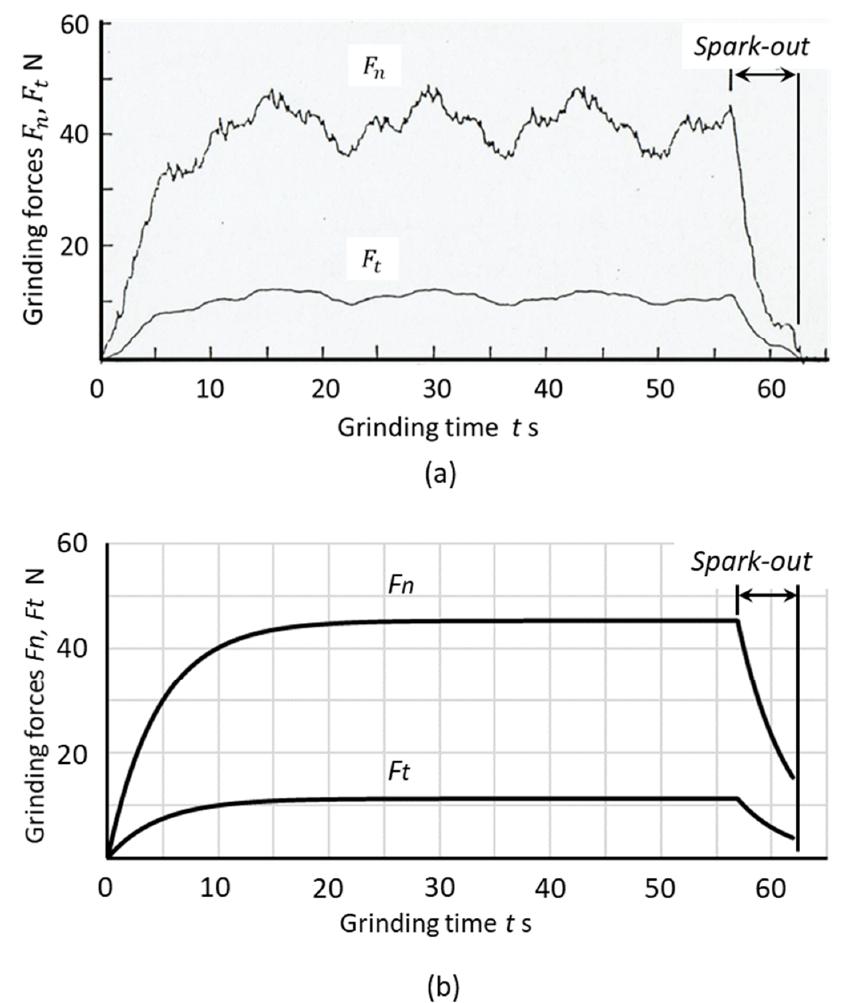
Figure 21. Grinding test results and simulation for infeed centerless grinding. ( a ) Test results of infeed centerless grinding of glass; ( b ) Simulation results of infeed centerless grinding.